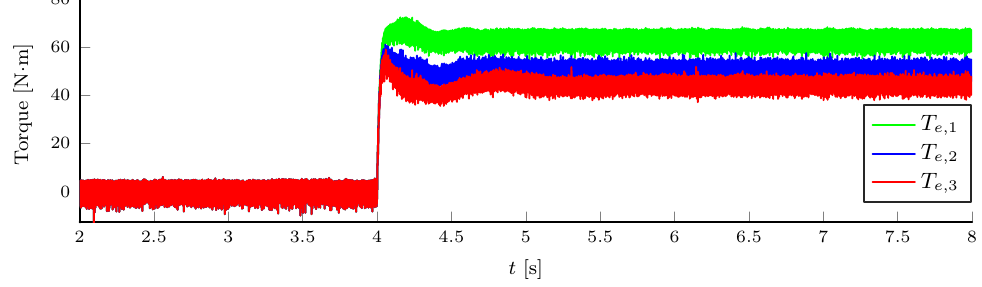
Figure 23. Electromagnetic torques; current-source control. Figure 23 shows electromagnetic torque for all motors. The initial electromagnetic t < 4 s) is zero for all motors since they have already reached free-acceleration torques (2 ≤ speed (refer to Figure 20). After t = 4 s, each motor produces a different electromagnetic torque response, corresponding to the differences in load torques and motor